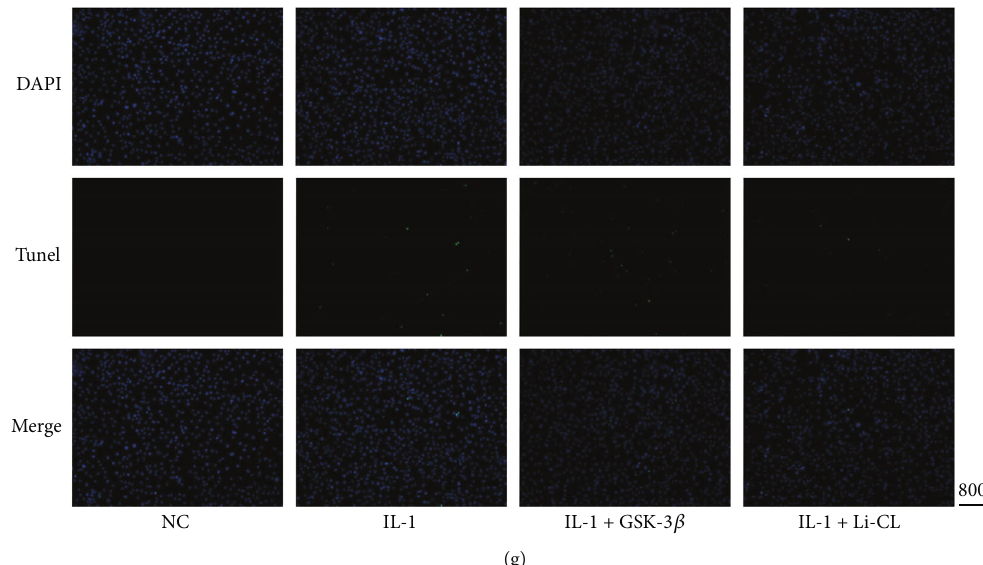
Figure 3: GSK-3 β promotes apoptosis of IL-1 β -impaired BMSCs. (a)-(d) The expression level of caspase 9, cleaved caspase 9, caspase 3, cleaved caspase 3, Bax, Bcl-2, and Survivin were detected by western blotting. Flow cytometric analysis (e) and (f) and TUNEL staining (g) were performed to assess the number of apoptotic cells. All results are expressed as the mean ± SD ( n = 3 ). NS: not signi fi cant, ∗ P < 0 : 05 . Bar = 800 μ